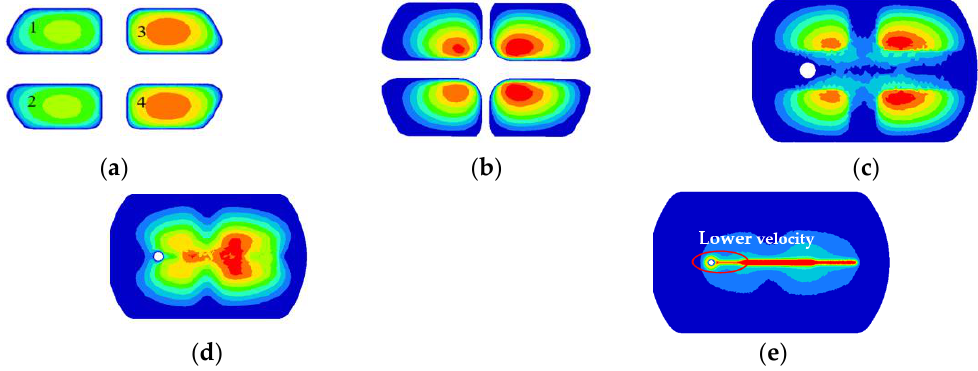
Figure 6. Metal flow at different stages during the whole extrusion process: ( a ) velocity distribution at the entrance of the portholes; ( b ) velocity distribution in the portholes, ( c ) metal flowing the welding chamber, ( d ) metal flowing in the mid-height welding chamber, and ( e ) velocity distribution at the entrance of the die orifice.